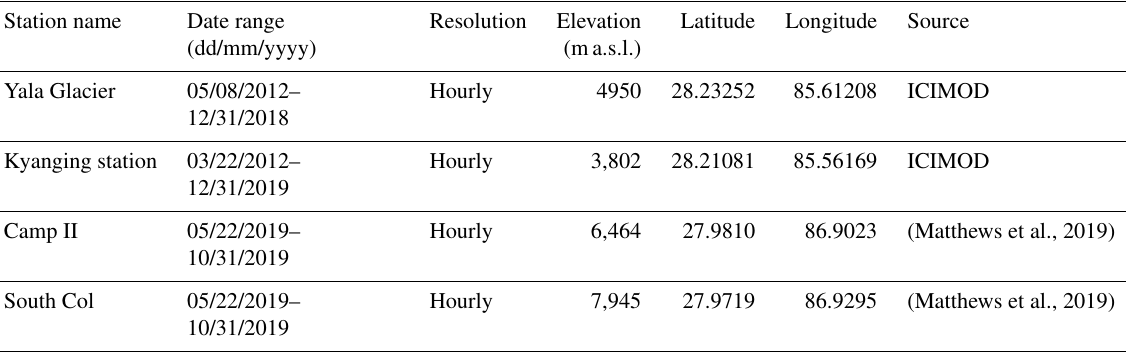
Table 2. Sources of air temperature data used to calculate 3d average temperature–elevation lapse rates within the central Himalaya for the 2018 calendar